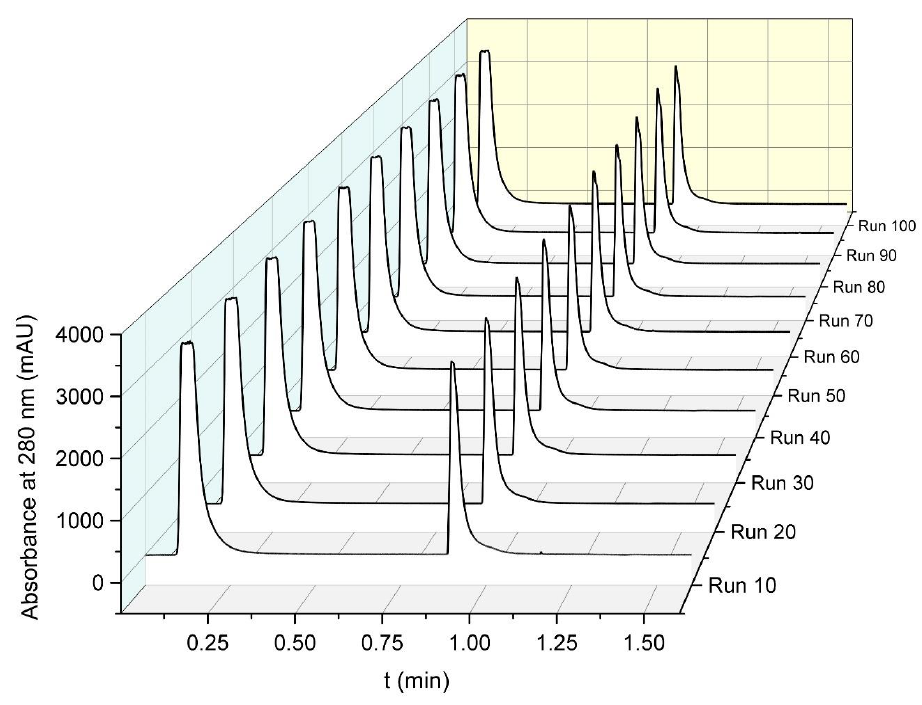
Figure 9. Representation of 100 extraction/elution cycles of the VitraPOR 5 column. This graph shows an overlay of IgG determinations from human plasma.